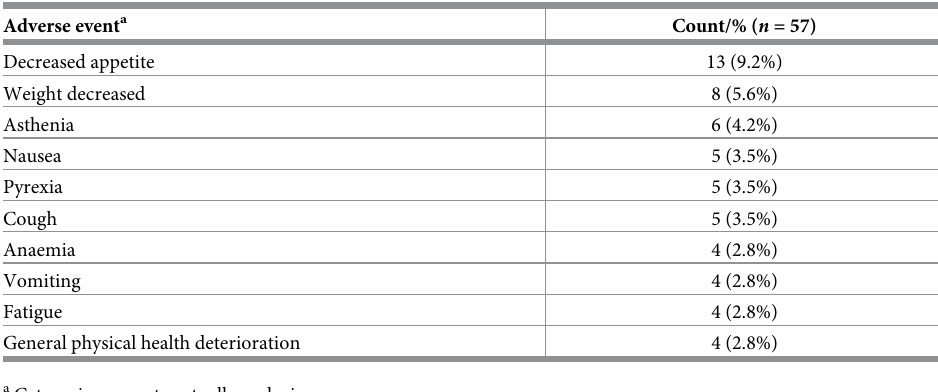
Table 2. Ten most frequently reported adverse events.